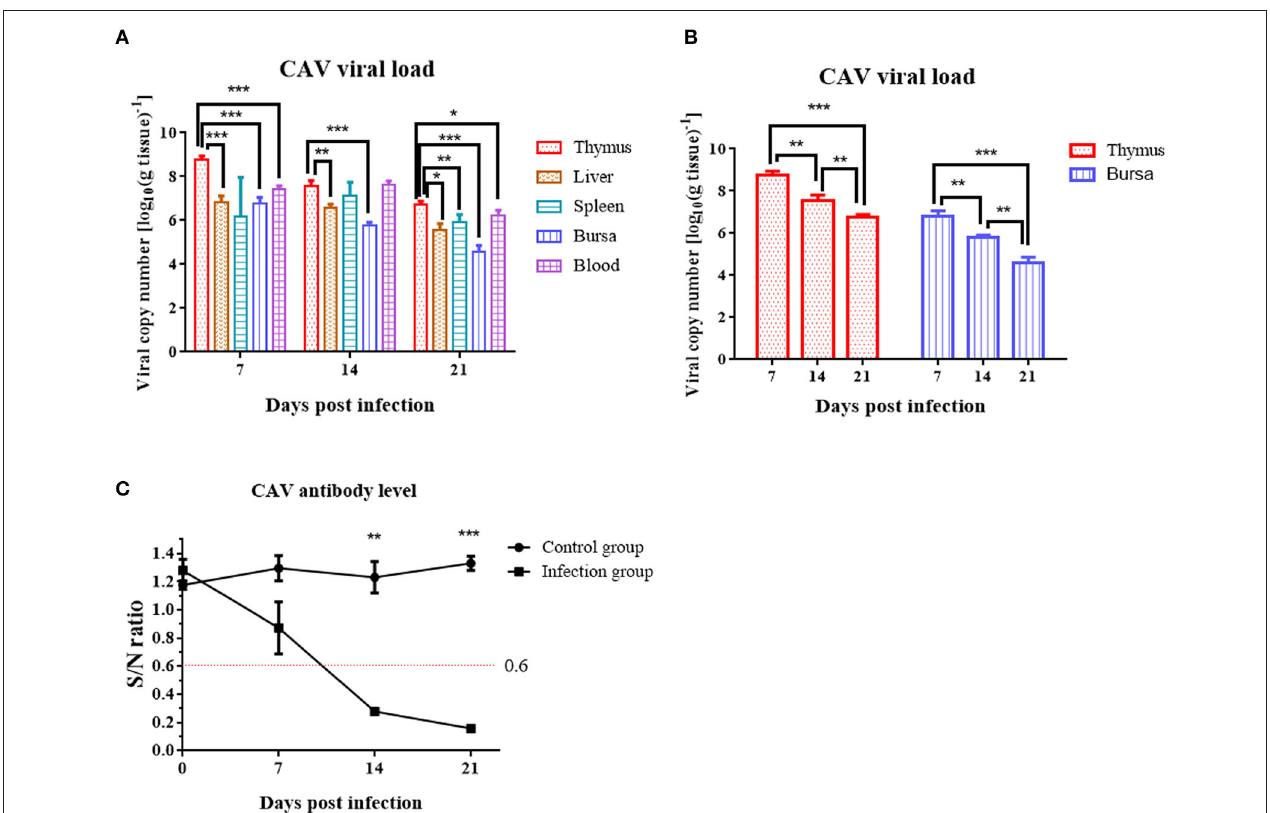
FIGURE 5 | Viral loads in various organs and dynamic detection of the CAV-specific antibody level at 7 dpi, 14 dpi, and 21 dpi. (A) Viral loads in various organs. The copy number of the thymus compared to blood, liver, bursa, and spleen at 7 dpi, 14 dpi, and 21 dpi. (B) Viral loads in thymus and bursa. (C) Dynamic detection of the CAV-specific antibody. An S/N value below 0.6 was considered CAV antibody positive. The unpaired t -test was used for statistical comparison. * p < 0.05, ** p < 0.01, *** p <